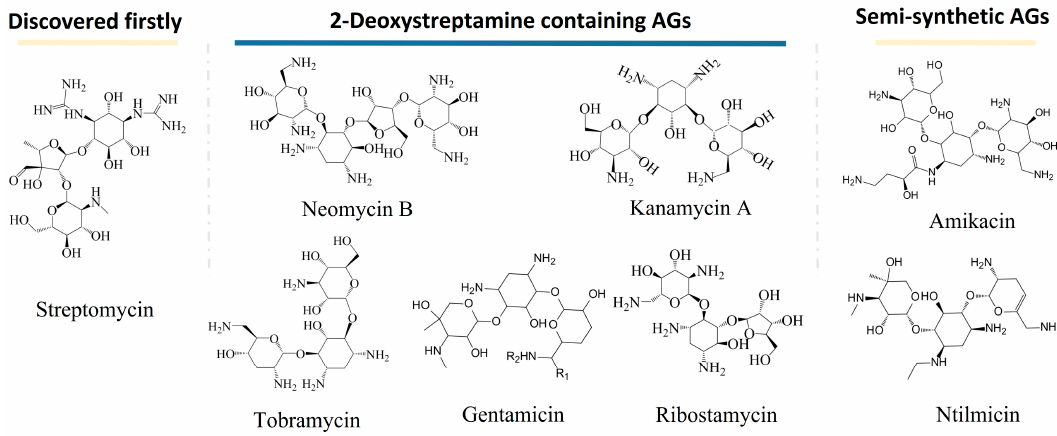
Figure 1. Structures of typical aminoglycosides (AGs).